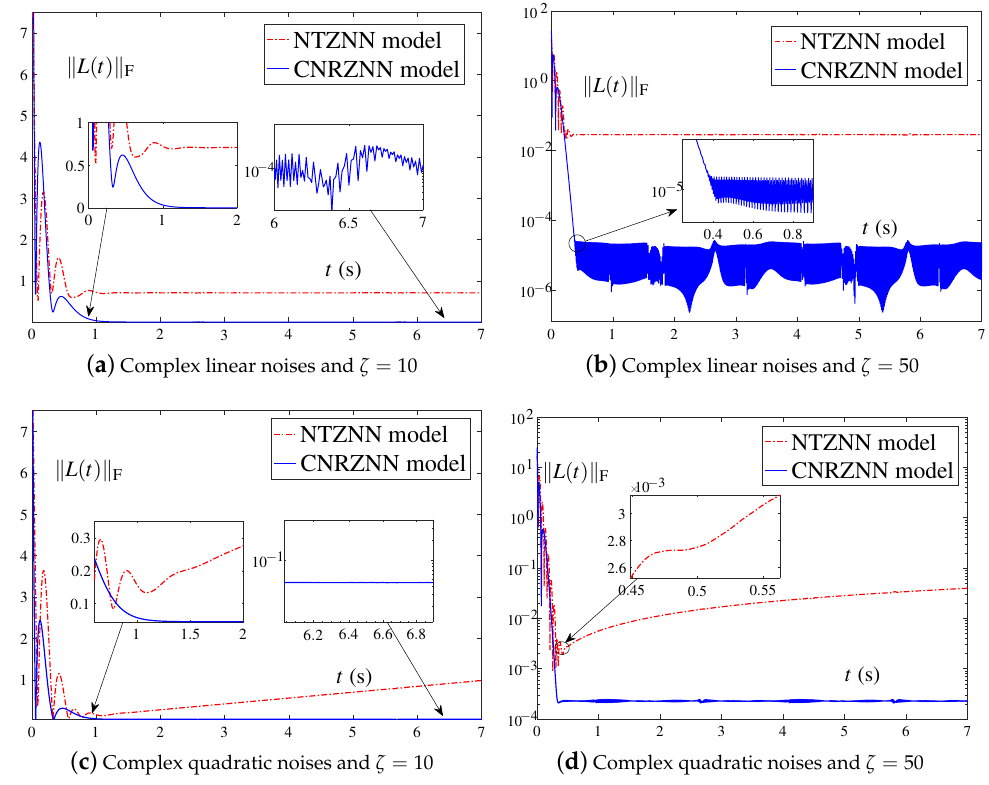
Figure 7. CNRZNN model (7) and NTZNN model (9) for solving CTDLE (15) under complex linear noises [( 50 + 50 i ) t ] 2 × 2 and complex quadratic noises [( 5 + 5 i ) t 2 ] 2 × 2 . ( a ) ζ = 10 and the complex linear noises. ( b ) ζ = 50 and the complex linear noises. ( c ) ζ = 10 and the complex quadratic noises. ( d ) ζ = 50 and the complex quadratic noises. Table 2. Comparison of steady-state residual error values between NTZNN model and CNRZNN model under different design parameters and